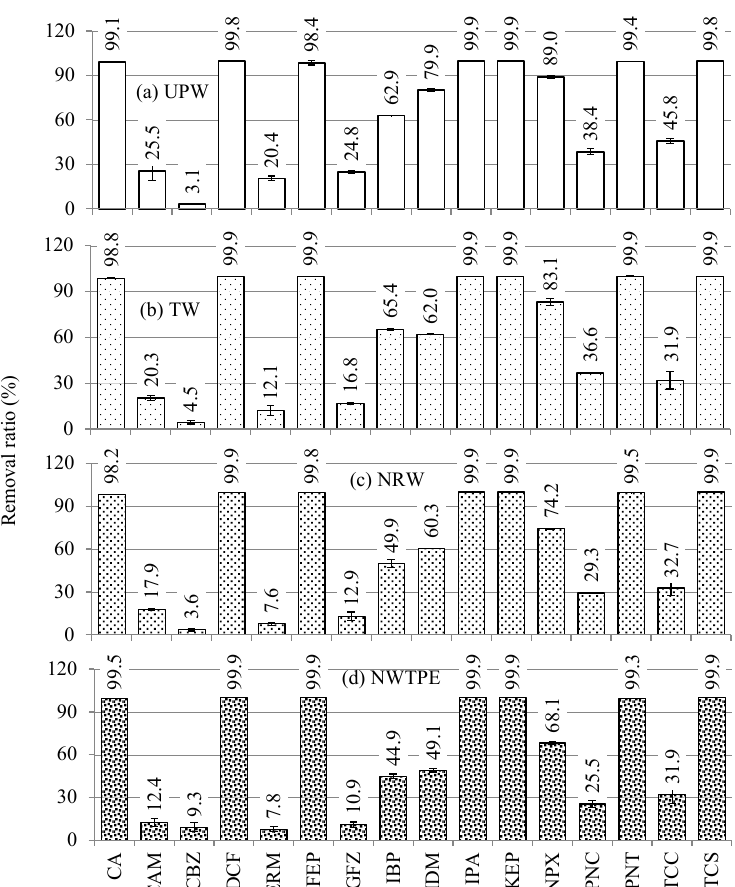
Figure 2. Removal ratios for PhCs (n = 3, 30 min reaction) by UVC photolysis in simulated mixed solutions using ultrapure water (UPW), tap water (TW), Neya River water (NRW) and Nakahama wastewater treatment plant effluent